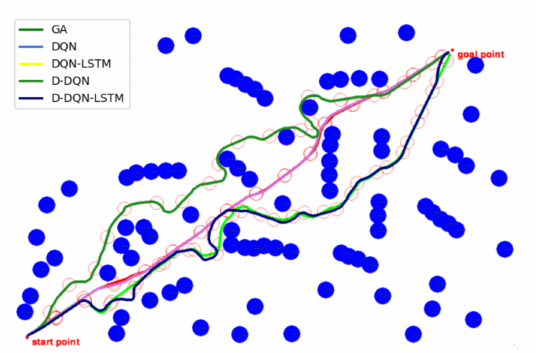
Figure 10. Path planning capabilities of five algorithms in a static environment.